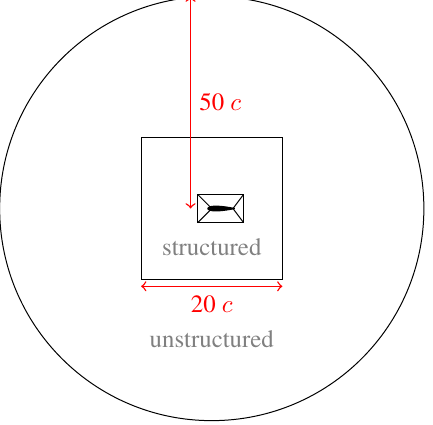
Figure 5. Computational domain used in the validation step.